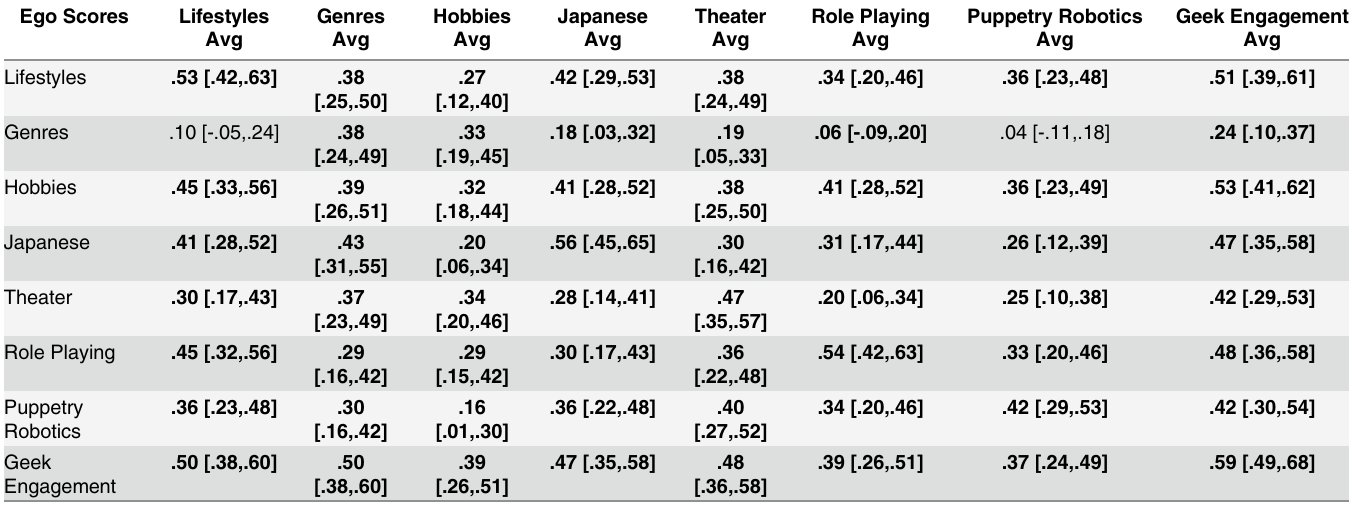
Table 8. Correlations between Ego Geek Scores and the Average Geek Scores of their Networks.